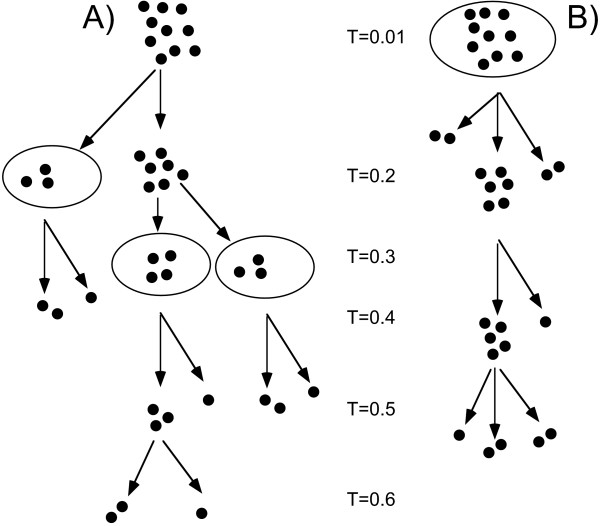
Detection of leaf clusters shown as ellipsoids. The minimal number of points in the leaf cluster is C = 3. The initial clusters contain 10 points each at T = 0.01 for both panel A) and B). On panel A) the cluster melts on two leaf clusters shown by ellipses. On panel B) the leaf cluster is the initial cluster. The leaf clusters are identified at different temperatures.